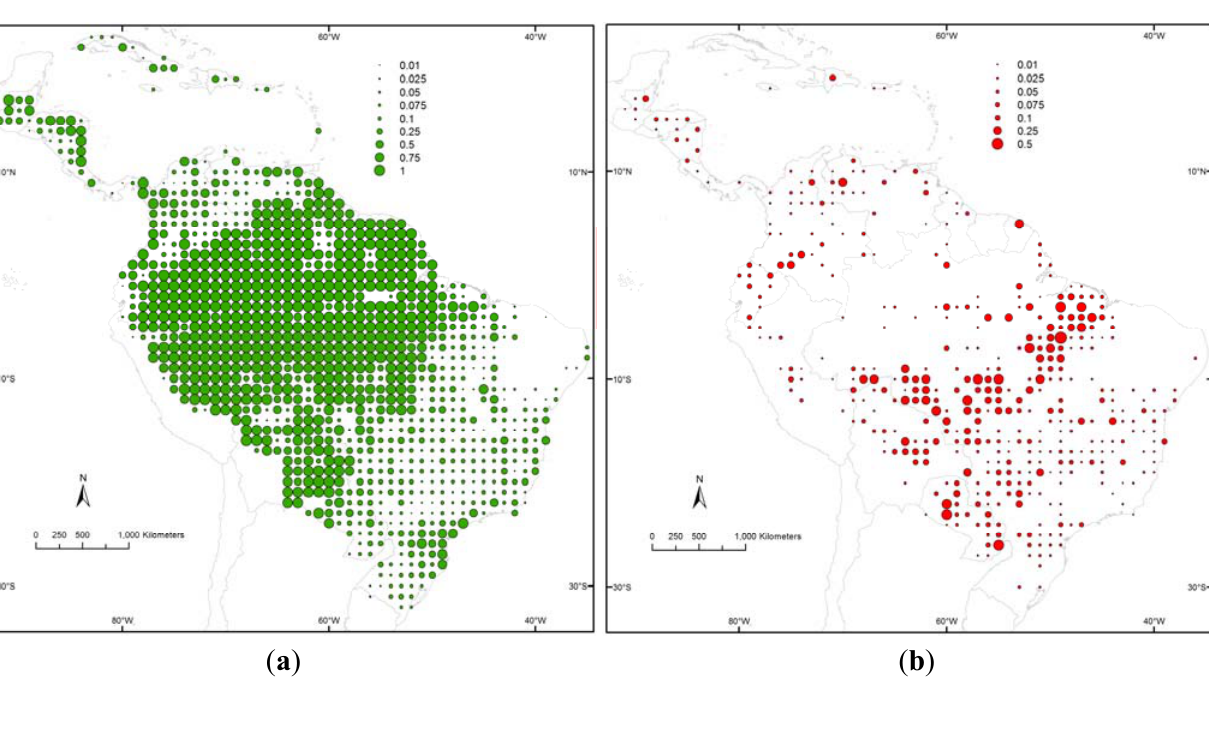
Figure 4. Maps of results obtained for all sample sites: ( a ) forest cover proportions for year 2000 (range: from 0 to 1); ( b ) proportions of gross forest loss from 1990 to 2000; ( c ) proportions of gross forest loss from 2000 to